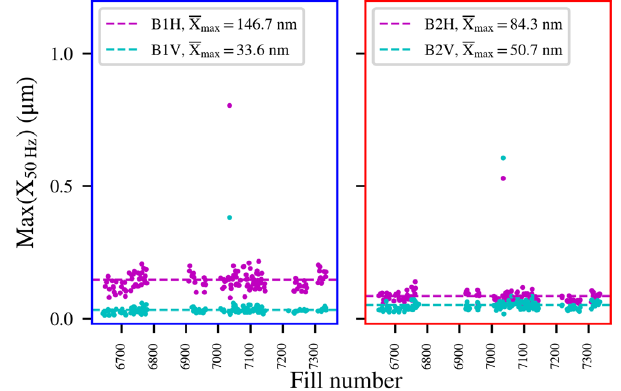
FIG. 17. The spectrum of the horizontal (magenta) and vertical (cyan) plane of Beam 1 (left) and 2 (right) in stable beams, normalized with the corresponding β -functions.